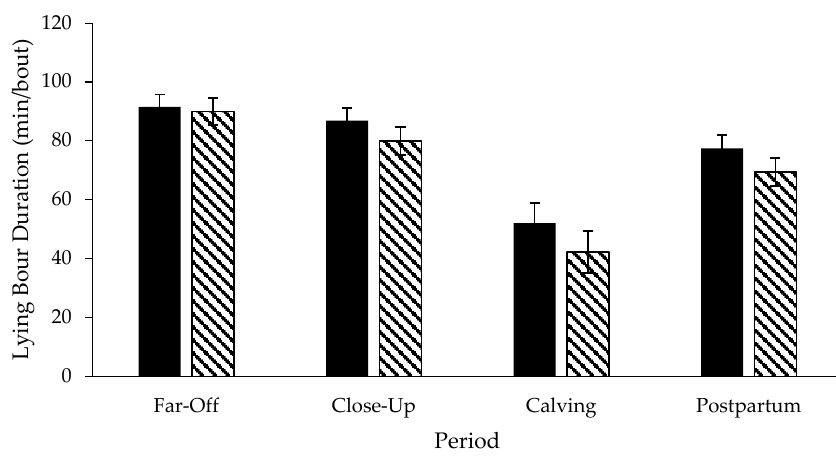
Figure 5. Lying bout duration of Holstein cows managed in freestalls (solid bars; n = 14) or on pasture